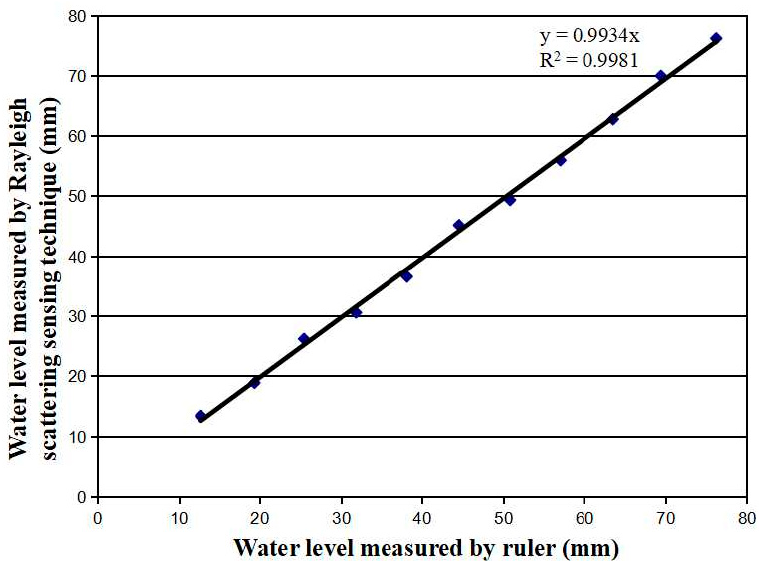
Figure 8. Water level was measured by means of both the fiber sensor and the ruler with a correla- tion factor of 0.9934, although the sensing fiber was affected by the vibration of a running car engine. Finally, we examined the repeatability of the fiber sensor measurement. A 0.35 m-long sensing fiber was connected to OBR4400 via a ~60 m-long telecom fiber SMF28. A sensing fiber segment that was about 0.19 m long was submerged in water while the rest remained